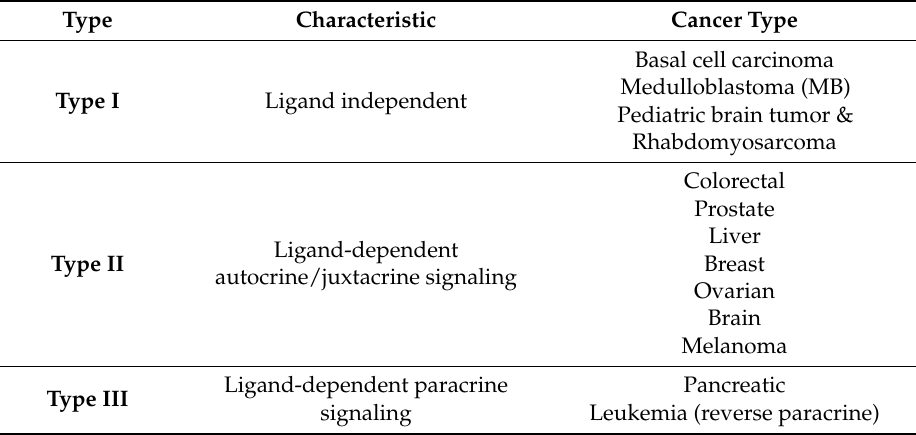
Table 1. Hedgehog signaling activation in